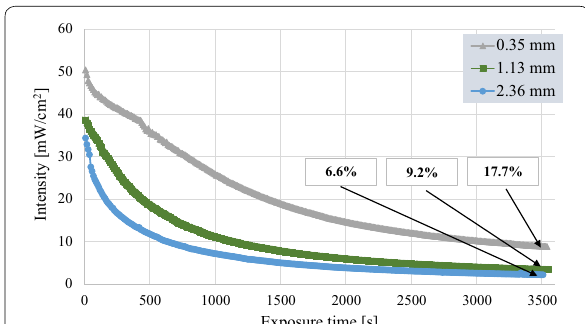
Fig. 5 405 nm intensity attenuation through the SU-8 film over the exposure